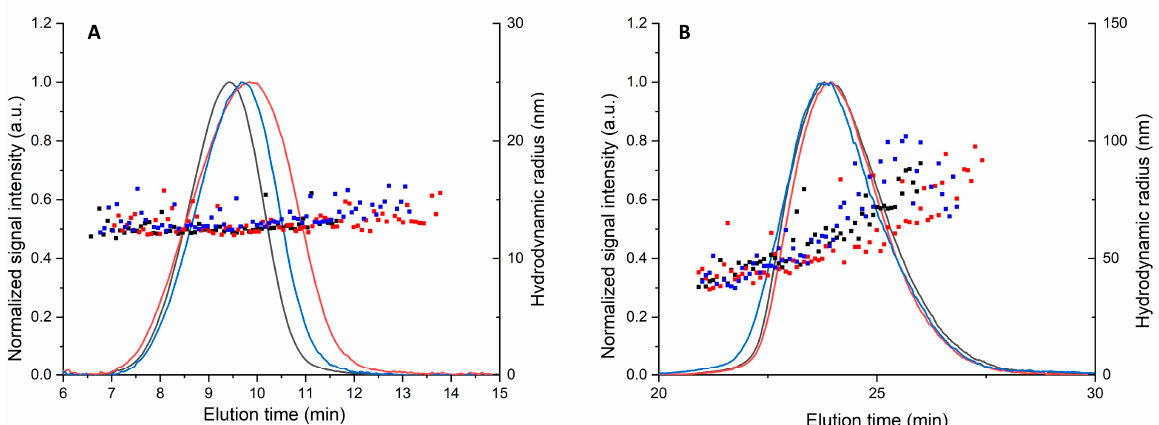
Figure 1. Asymmetric flow field-flow fractionation (AF4)-dynamic light scattering (DLS) data for ( A ) polymeric micelles (p22) and ( B ) polymersomes. Scattered dots indicate the hydrodynamic diameters, and the lines show normalized signal intensities at 280 nm. The measurements were done at 37 °C in porcine vitreous immediately after exposure (black) and after incubation of one day (red) and seven days (blue). Table 2. Mobility parameters of polymersomes in the vitreous. D v was experimentally derived from single particle analysis based on mean square displacement of the particles, and D w was calculated using Stokes–Einstein